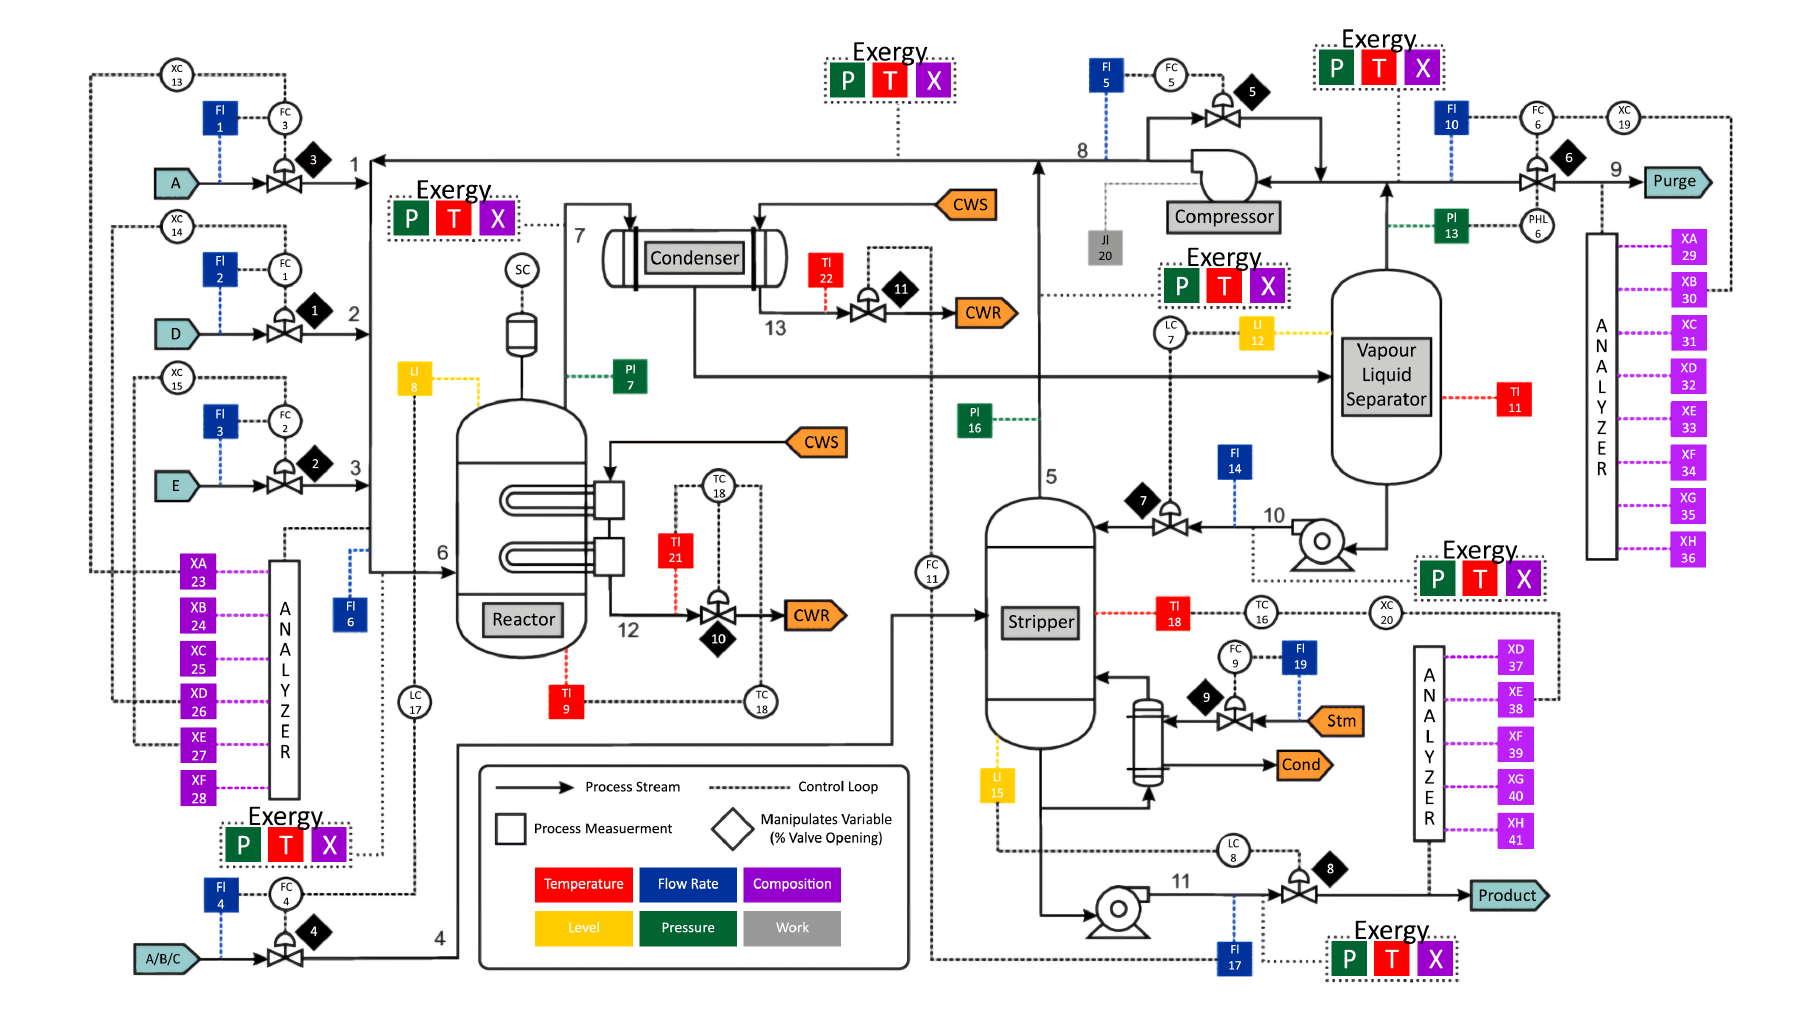
Figure 4. The TE process